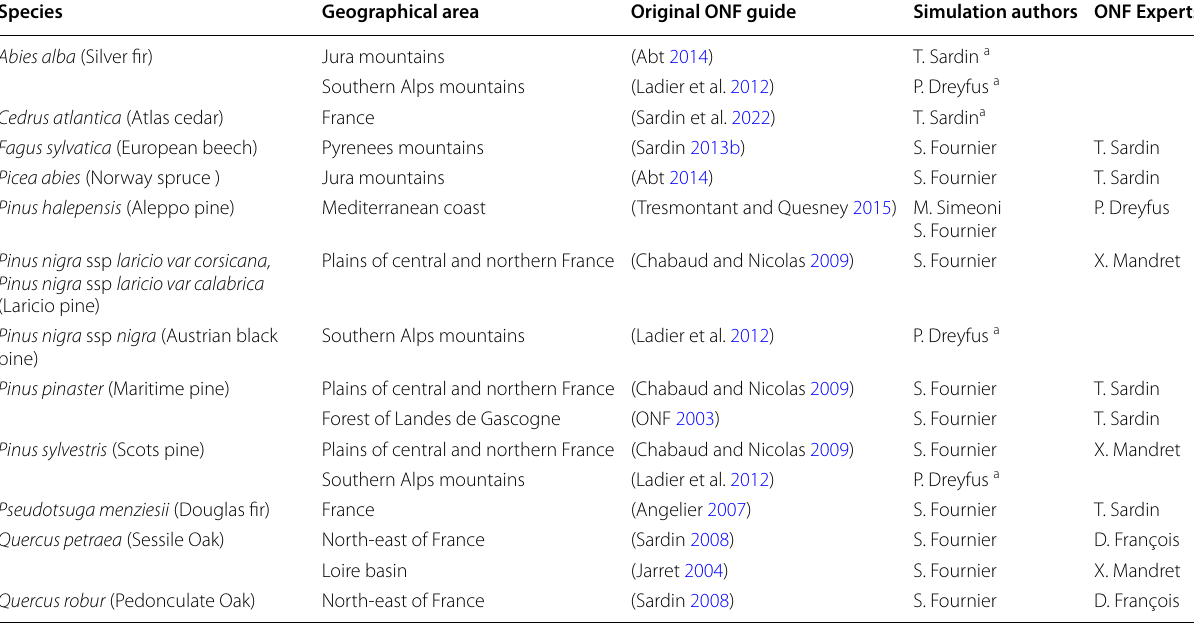
Table 3 Synthesis of people involved in performing models for simulation on the one hand and in expertise for validation of simulation on the other hand, for each studied species. Authors of simulation models contributed to add silvicultural scenarios (SSCs) of the ONF guides in the database